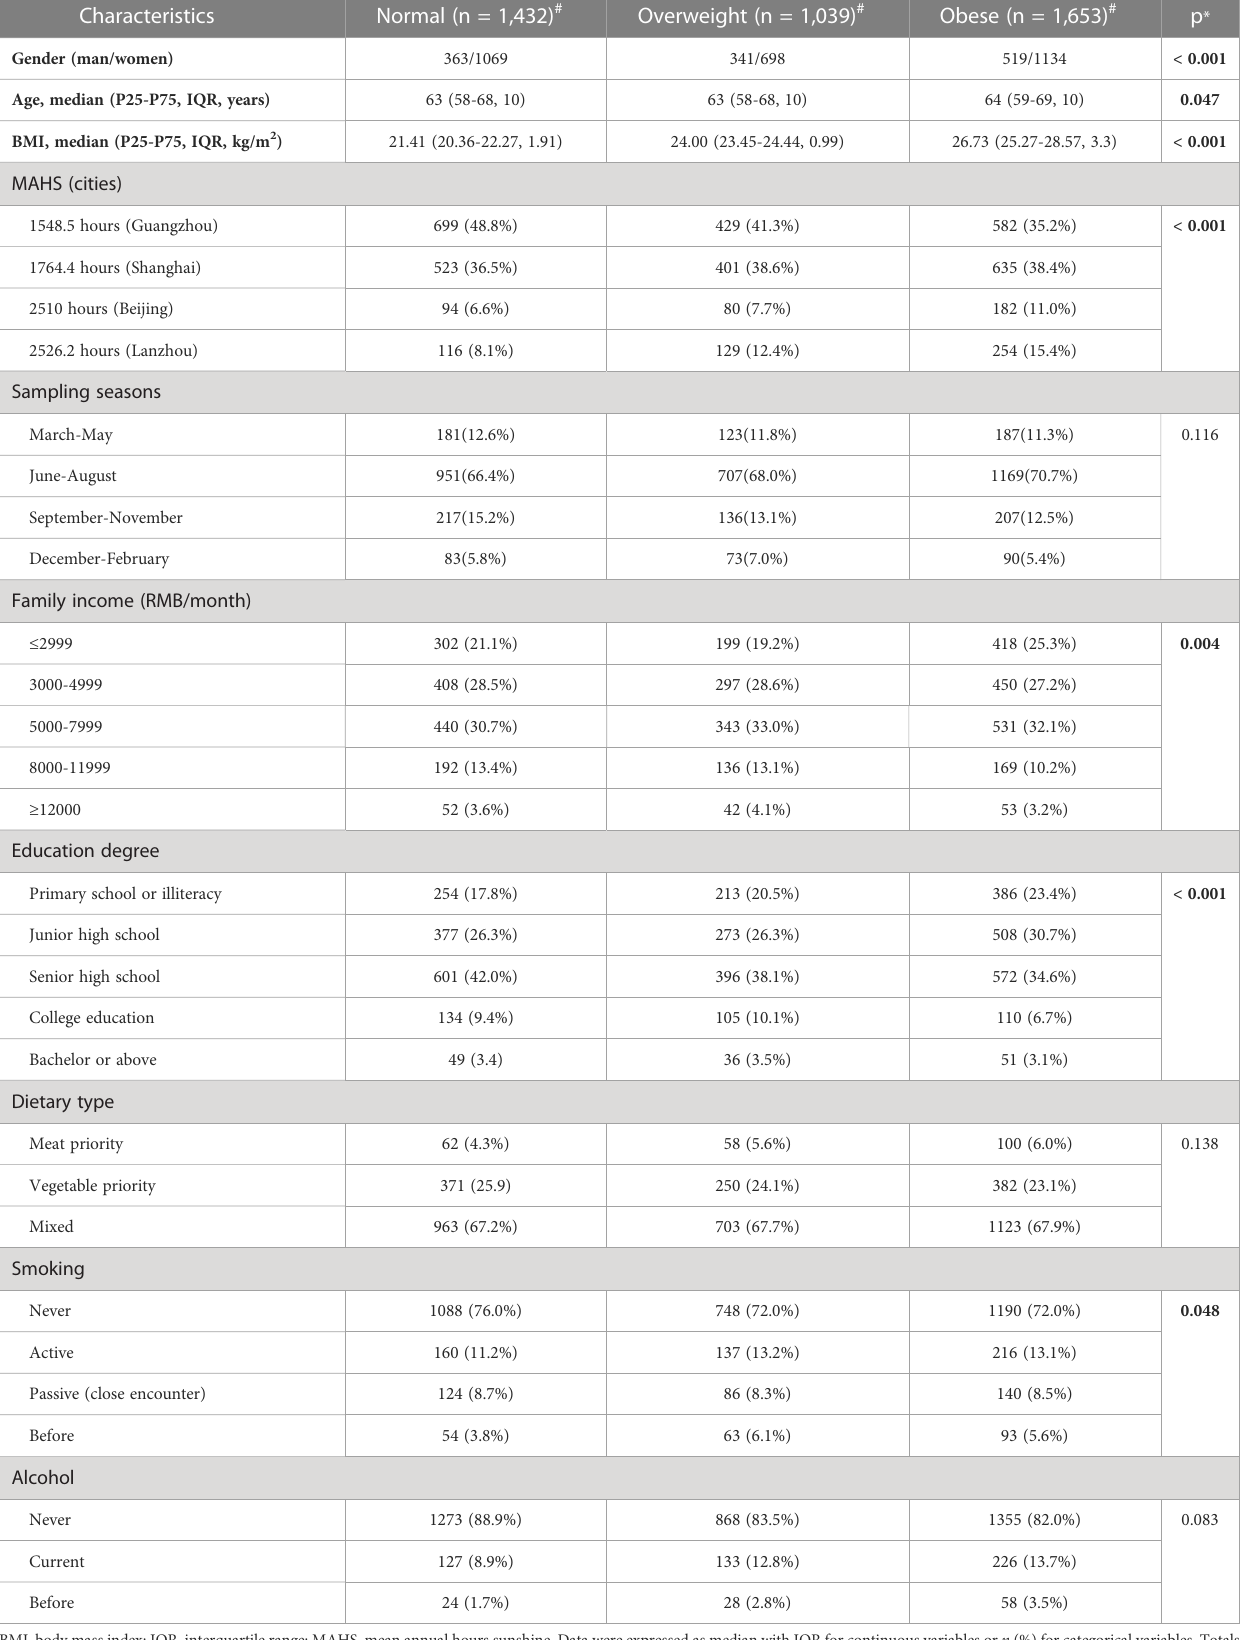
TABLE 1 Characteristics of included subjects in normal, overweight and obese groups (N =